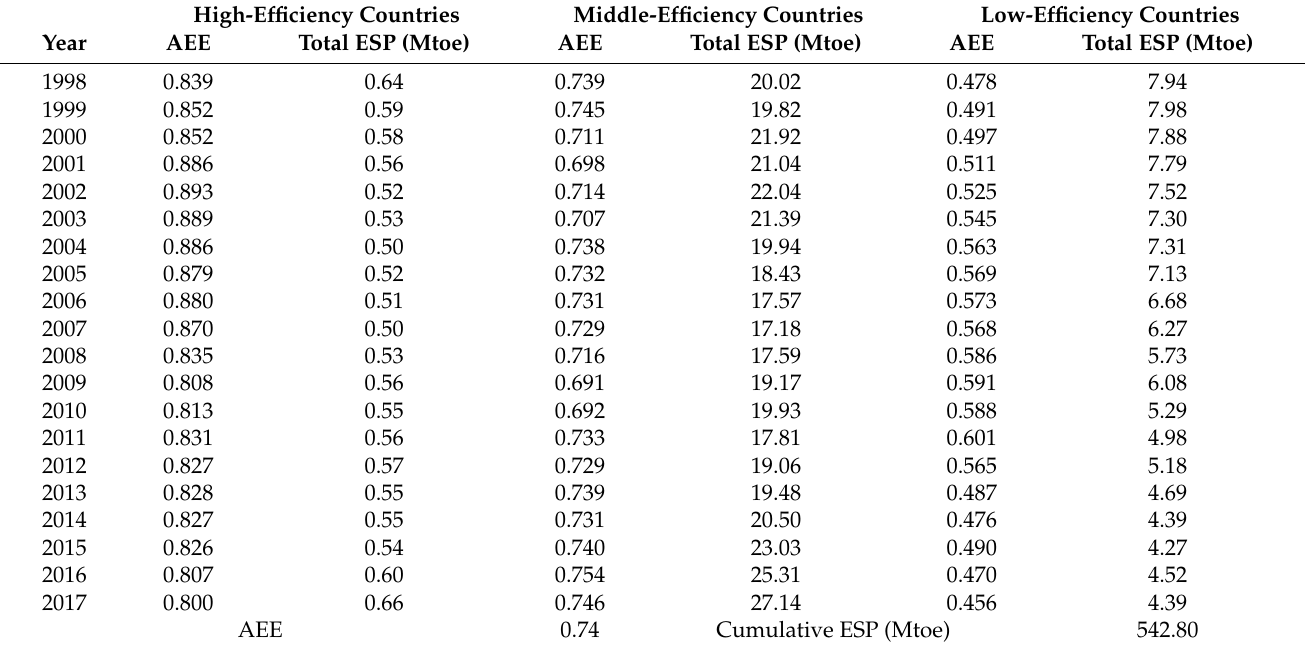
Table 5. Agricultural energy efficiency and energy-saving potential in the classification of energy efficiency (1998–2017). High-Efficiency